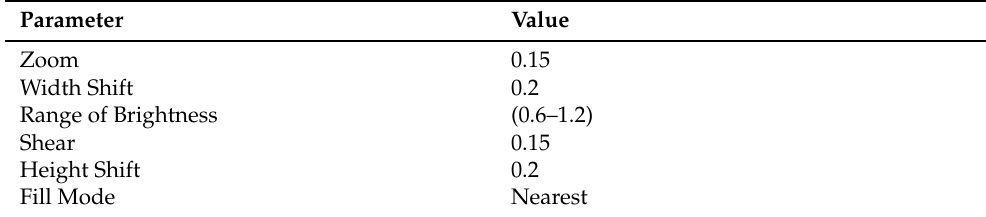
Table 4. Data Augmentation and Pre-Processing Parameter used in ImageDataGenerator of Keras.